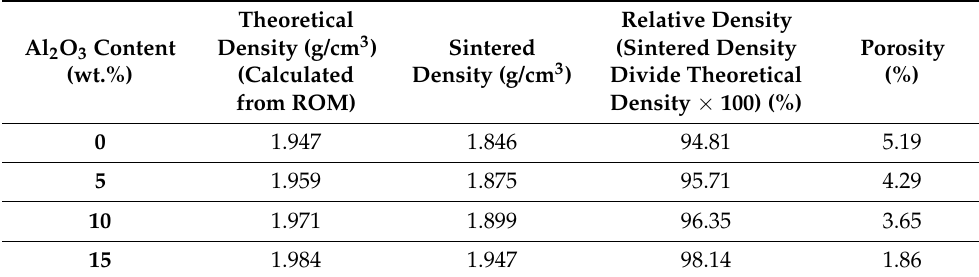
Table 2. Resultfortheoretical, relativedensityandpercentageporosityforMg-Zn/HAP/Al 2 O 3 composite.